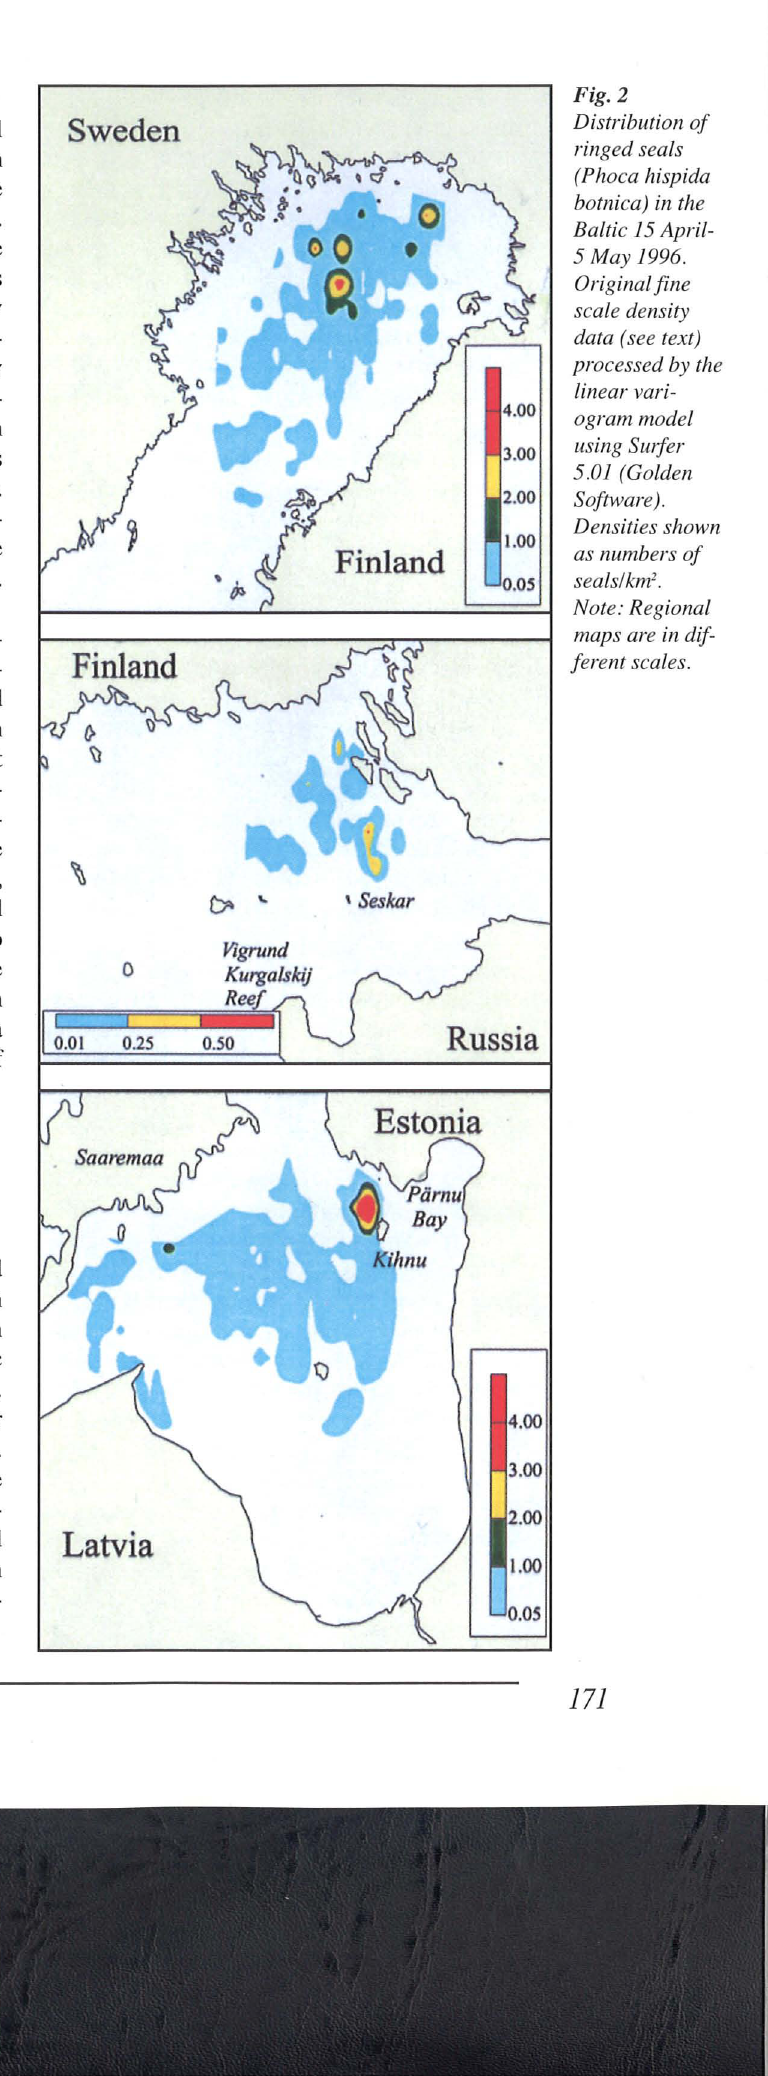
Fig. 2 Distribution of ringed seals (Phoca hispida botnica) in the Baltic 15 April- 5 May 1996. Original fine scale density data (see text) processed by the linear vari ogram model using SUlfer 5.01 (Golden Software). Densities shown as numbers of